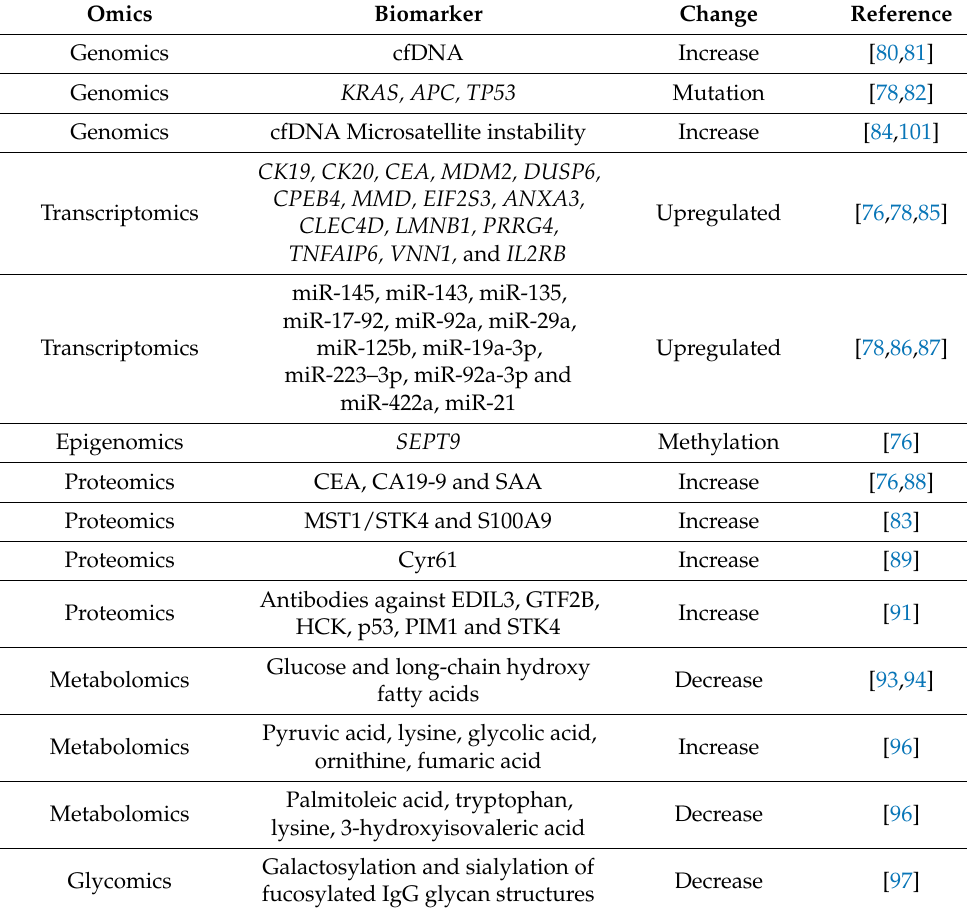
Table 4. Main biomarkers found in blood samples of CRC patients with different omics